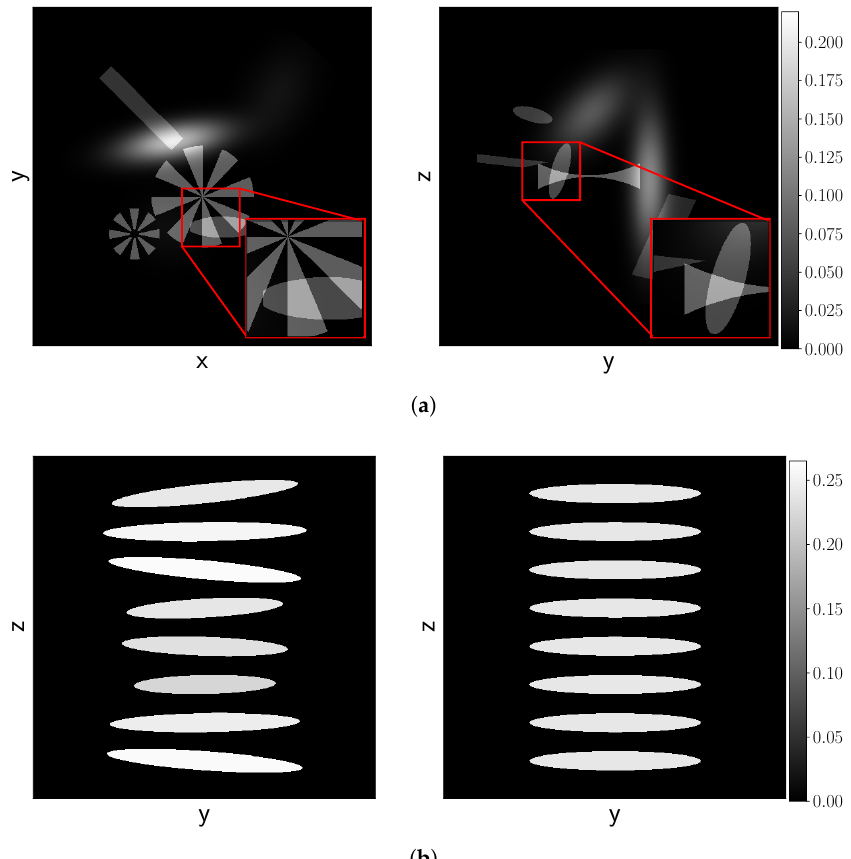
Figure 2. Examples simulated data. ( a ) Slices, ( Left ) z = 0, ( Right ) x = 0, of the Fourshape test phantom. This phantom is designed such that at least one of all objects can clearly be observed in the slices. ( b ) The x = 0 slice for a Random Defrise phantom ( Left ) and the standard Defrise phantom without alternating intensities from [53] ( Right